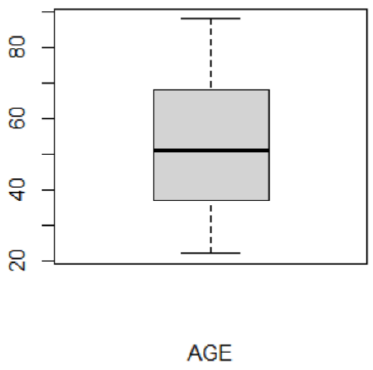
Figure 1. Boxplot of age distribution. Y-axis shows age in years. Surgical procedures carried out were classified as: 19 (33.93%) MRND plus TT, 19 (33.93%) MRND plus TT and CND, 3 (5.36%) MRND plus CND and 15 (26.79%) MRND only (Table 1, Figure 2). Among patients, left and right lymphadenectomy were equally distributed. The corresponding CI was (0.37, 0.63). It follows that the proportion was not statistically different from 0.5.